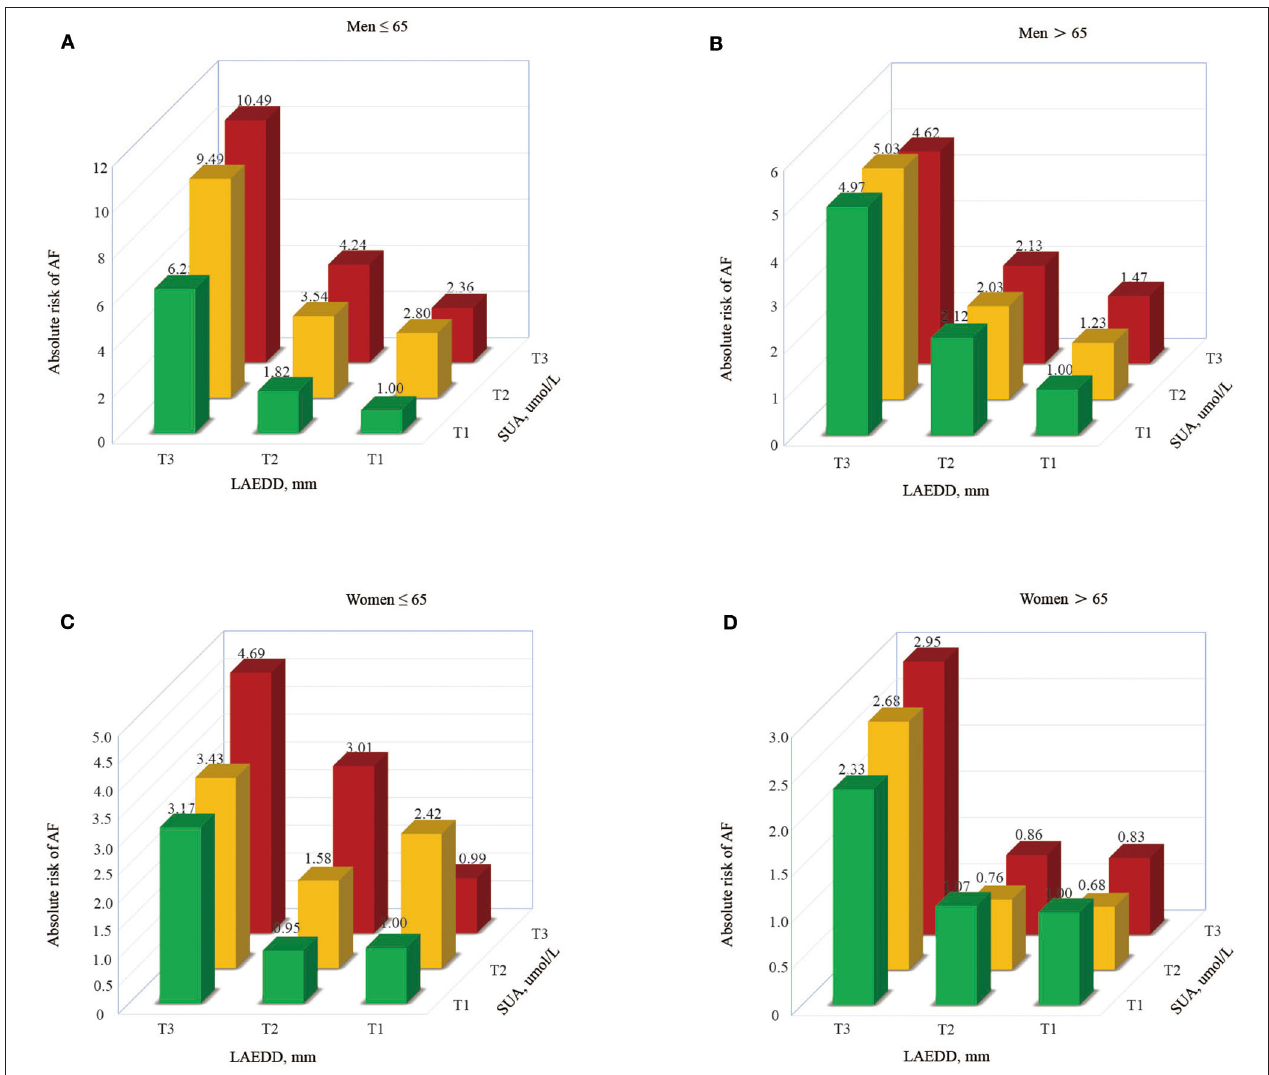
FIGURE 3 | The risk of AF based on LAD tertiles in patients grouped by SUA